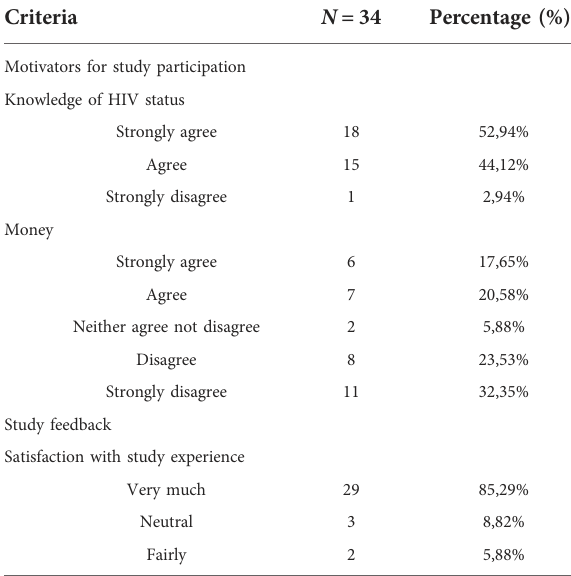
TABLE 5 Exit interview data collection